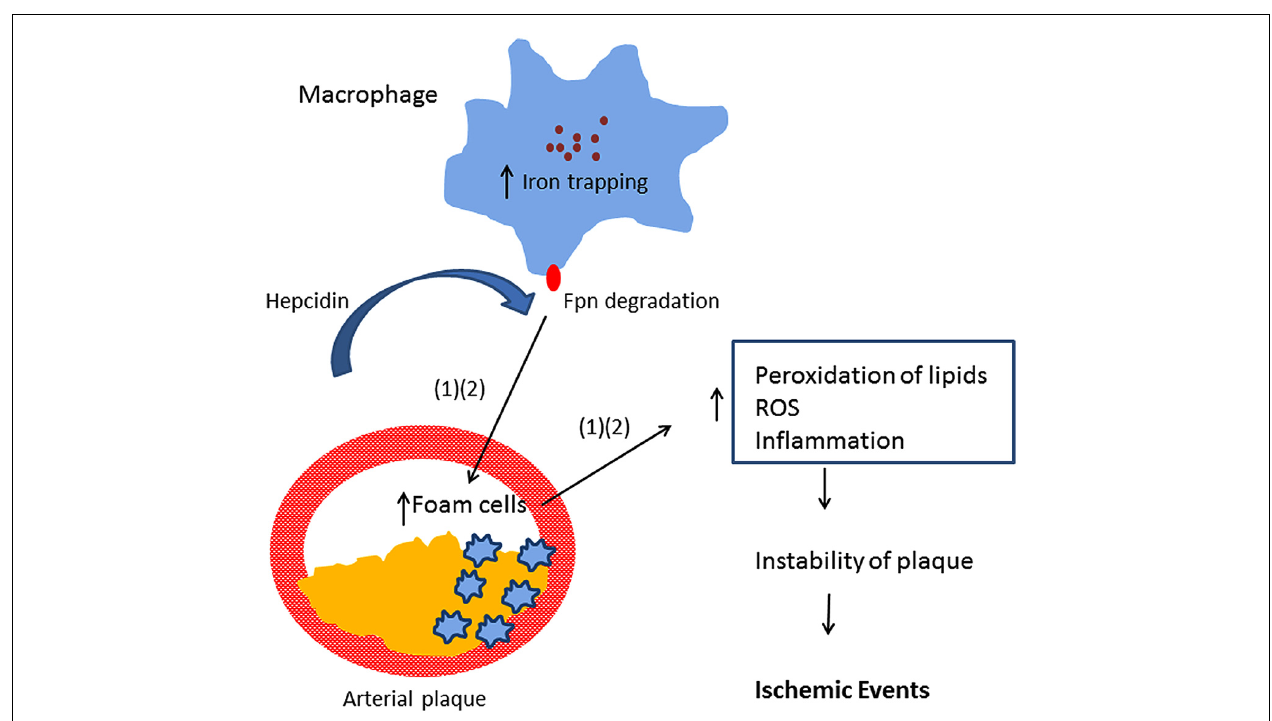
FIGURE 1 | Model showing iron retention in macrophages promotes arterial plaque destabilization (Sullivan, 2007;Theurl etal., 2008).